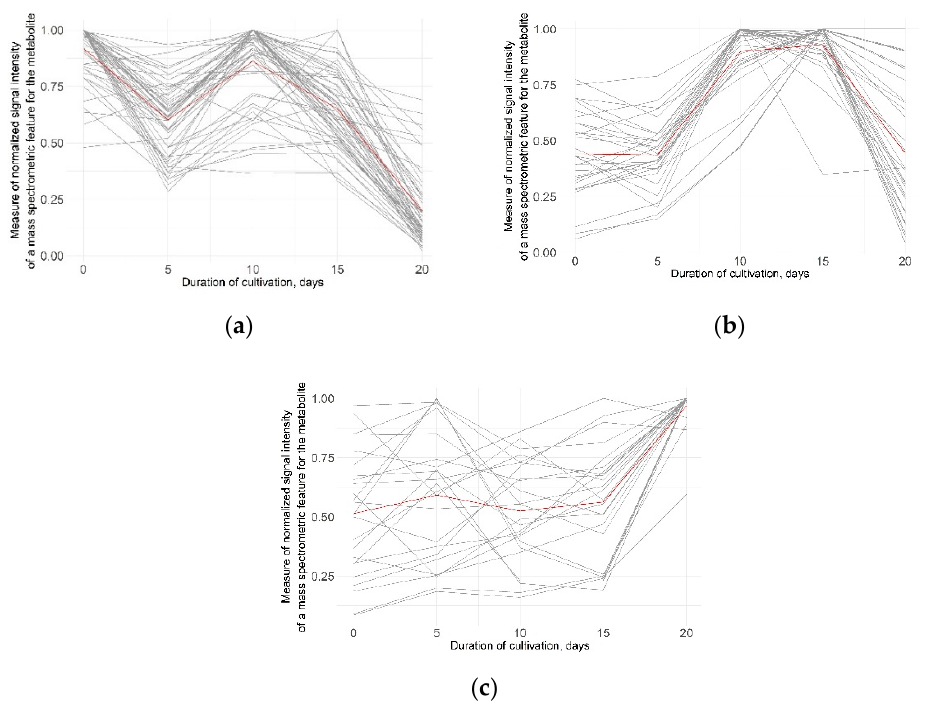
Figure 5. Three series of clusterization of identified metabolites (with a significant difference in abundance) using the K-means approach: ( a ) metabolites with a downward trend; ( b ) metabolites with peaking abundances at 10–15 days of cultivation; and ( c ) metabolites with zigzag fluctuations of abundances.